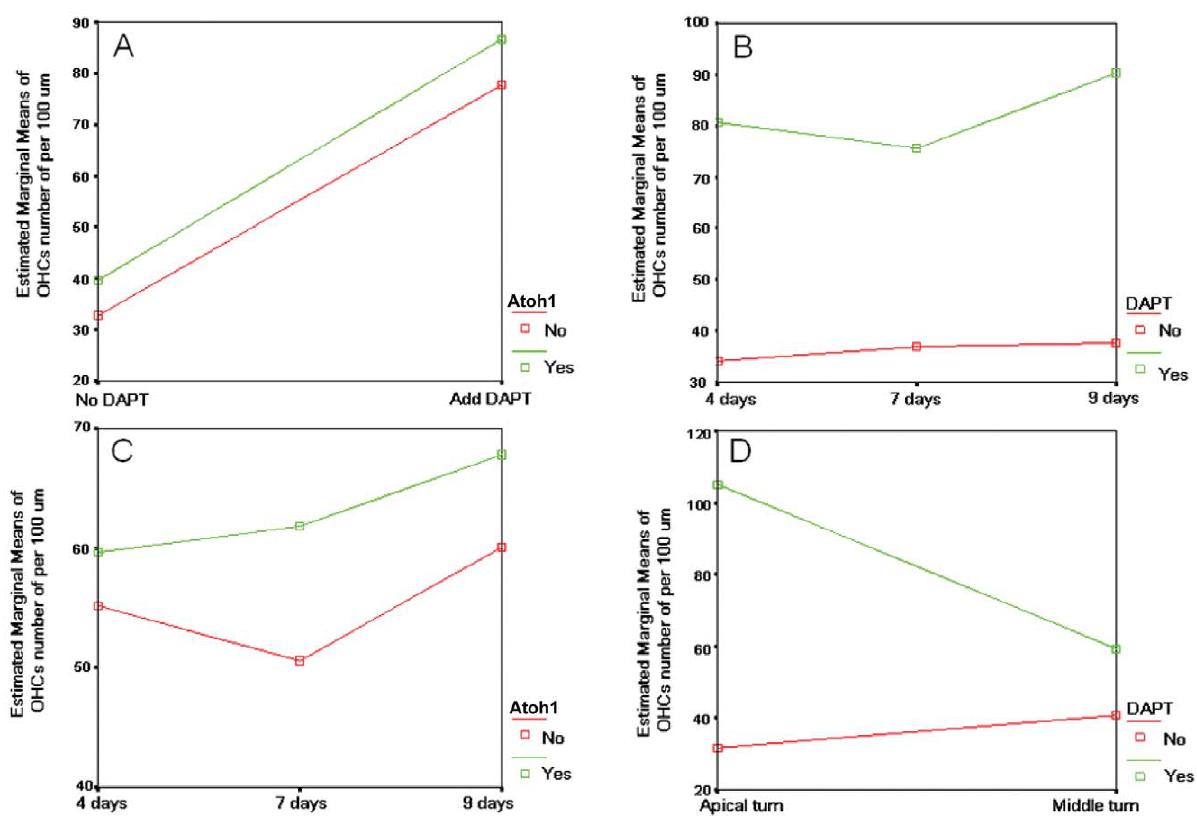
Figure 5. Interaction between treatment, culture time and hair cell location on the number of OHCs. A: The interaction curves are almost parallel, which means that their effects on the number increase of OHCs are independent. In other words, the number of OHCs increased similarly whether or not with Atoh1 over expression. B: In the group of 4, 7 and 9 days, the distance of the curves decreased first and then increased, which means that the single effect of on the number of OHCs is more significant during the 7 th –9 th days of than that of 4 th –7 th days. These result indicate that there were interaction between culture time and DAPT treatment. C: As for the case of Hath over expression, the distance between the two curves that represents with and without Atoh1 over expression increased during 4 th day–7 th day and then decreased during 7 th –9 th day, which means that there was interaction between culture time and Hath over expression. First agonize before the 7 th day and then antagonize after the 7 th day. D: DAPT treatment could induce more extra OHCs in the apical turn than that of middle turn, which means that the location of the hair progenitors reacted differently to the treatment of DAPT. In A and C, No: no Atoh1 over expression. Yes: With Atoh1 over expression. In B andD: No: no DAPT treatment, Yes: with DAPT